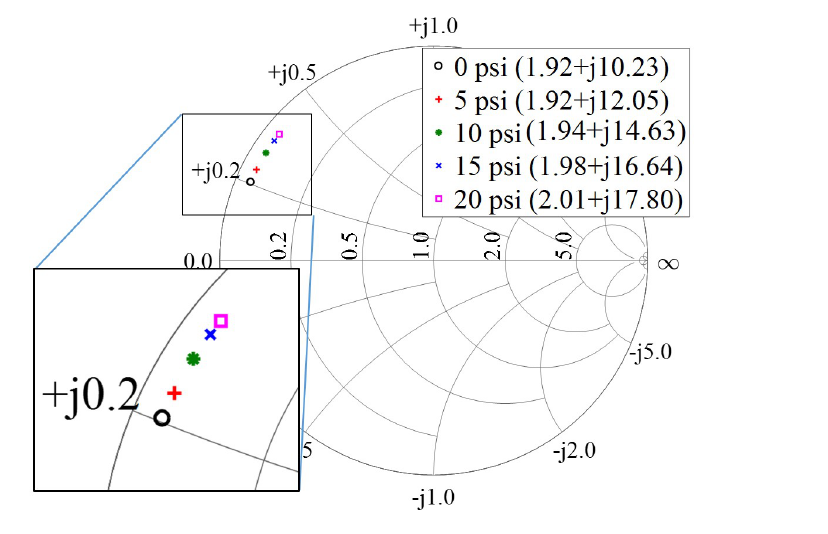
Figure 6. Measured impedance at 2 GHz for pressure range from 0 to 20 psi with a direct wired connection using vector network analyzer